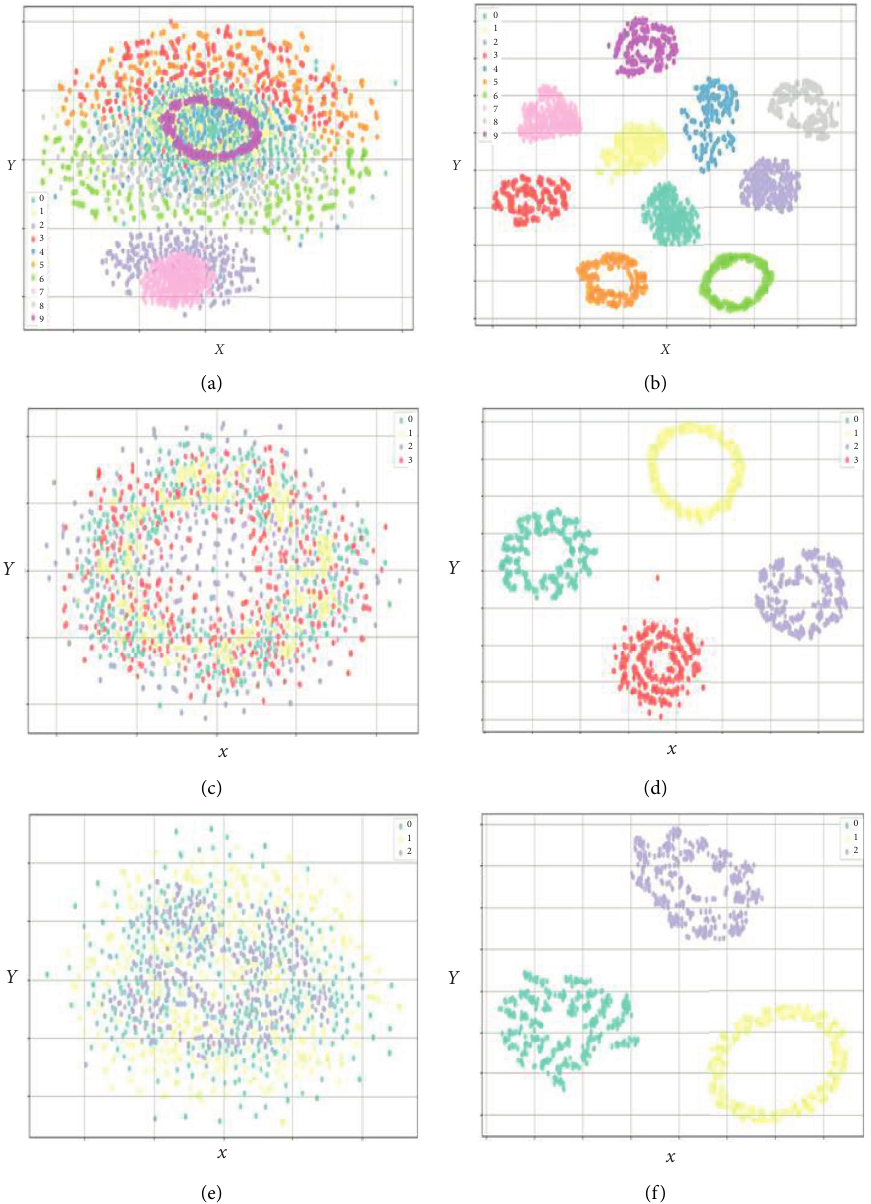
Figure 7: Feature visualization with (a) raw data on the CWRU dataset, (b) learned features on the CWRU dataset, (c) raw data on the Jiangnan dataset, (d) learned features on the Jiangnan dataset, (e) raw data on the Paderborn dataset, and (f) learned features on the Paderborn